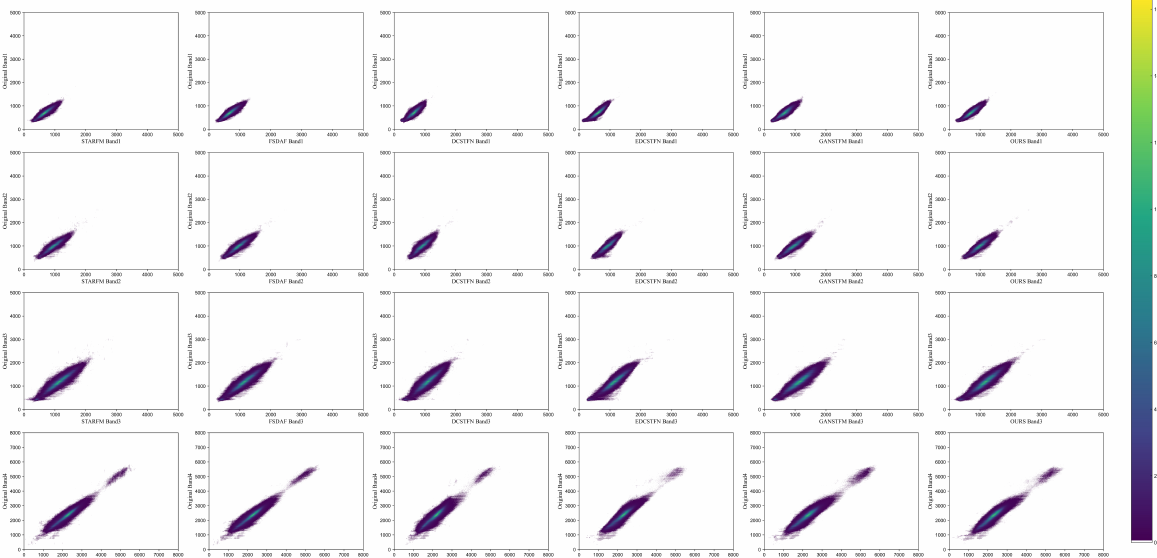
Figure 12. Global rendering result of the LGC dataset.